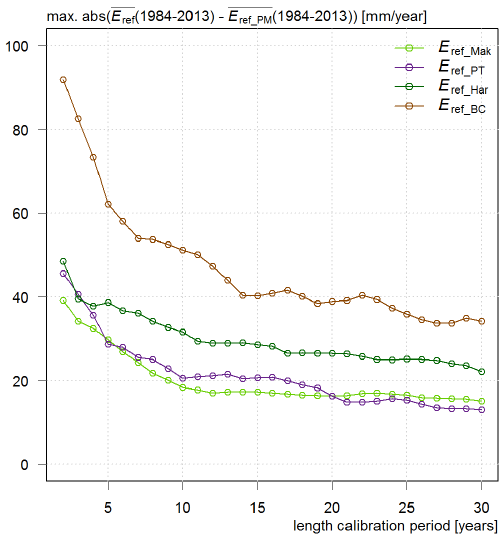
Figure 5. Maximum absolute deviation in 30-year average E ref from 30-year average E ref_PM for the period 1984–2013, as a func- tion of the length of the calibration